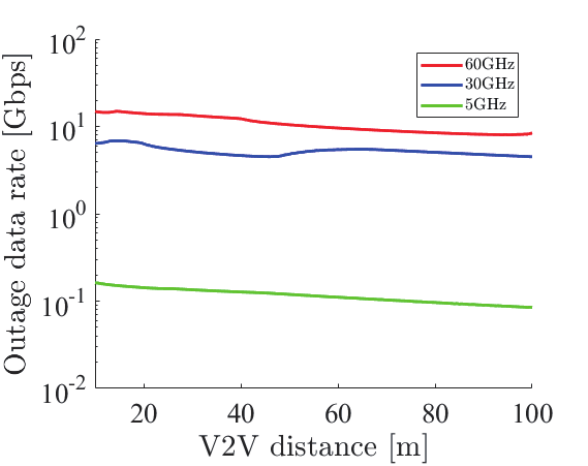
Figure 16. The 0.01% outage capacity with height diversity for 5, 30, and 60 GHz.